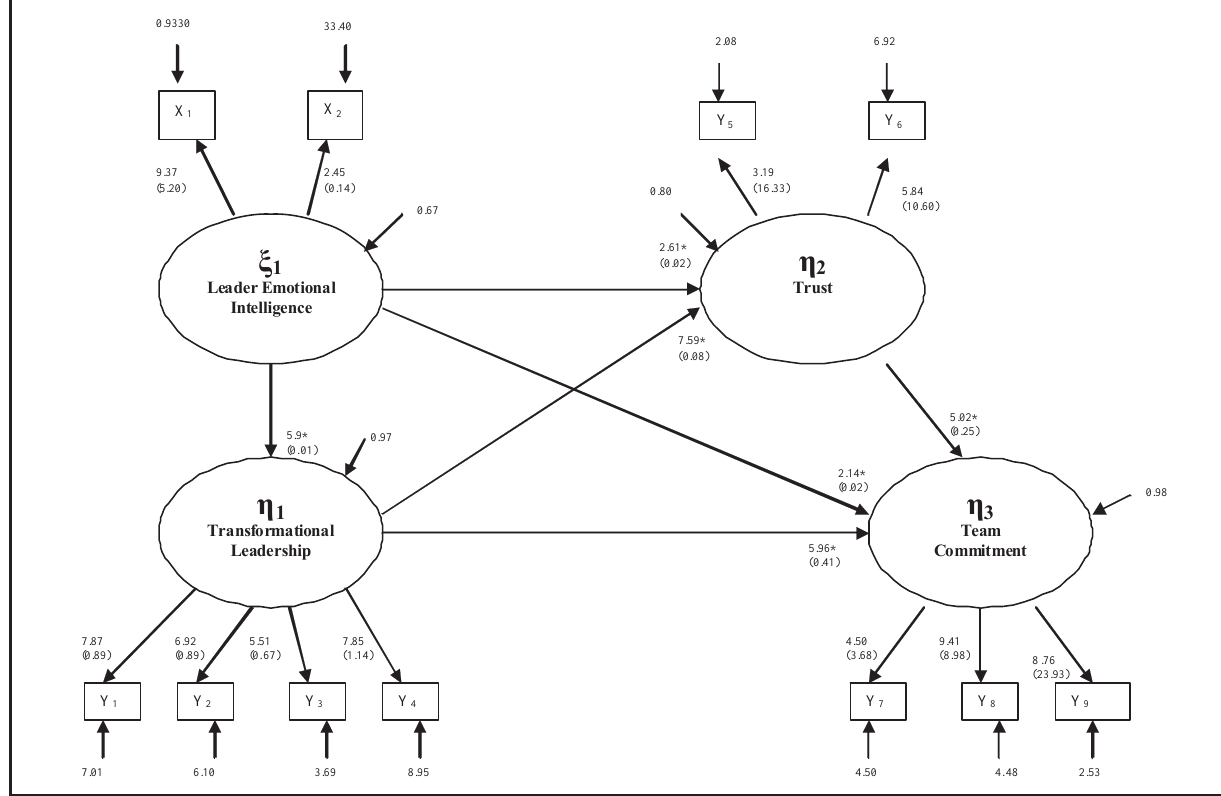
Manifest Variables/Indicators: X 1 = Understanding and displaying emotions, X 2 = Perception and control over emotions, Y 1 = TFL1, Y 2 = TFL2, Y 3 = TFL3, Y 4 = TFL4, Y 5 = Trust in the team leader, Y 6 = Trust in the co-workers, Figure 2 Structural Model with Maximum Likelihood Parameter Estimates for Leader EI, Transformational Leadership, Trust and Team Commitment